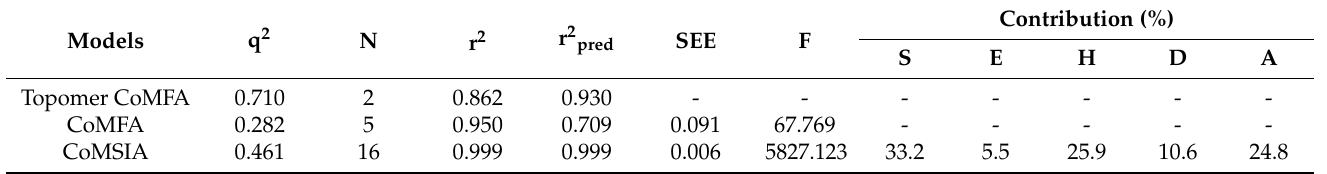
Table 2. Statistical results of QSAR models using Topomer CoMFA and CoMSIA.